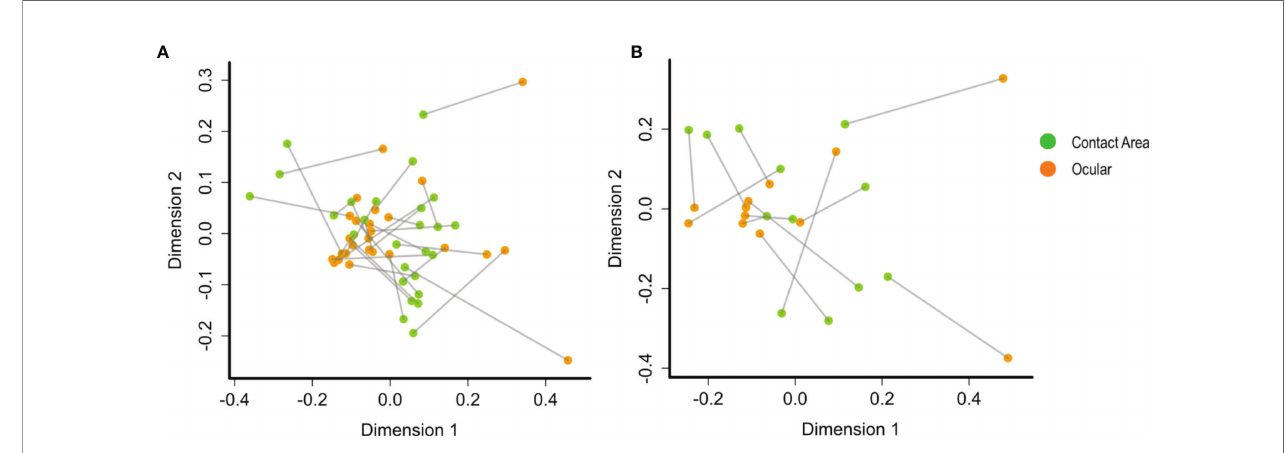
FIGURE 4 | PCA plots by procrustes analysis between the ocular and contact area data sets using Bray-Curtis distances and 10.000 iterations. At (A) TC1 (contact area: n =28; ocular: n = 28) and (B) TC2 (contact area: n = 14; ocular: n = 13). Every data point represents a single slit lamp sample coloured by sample site (orange =